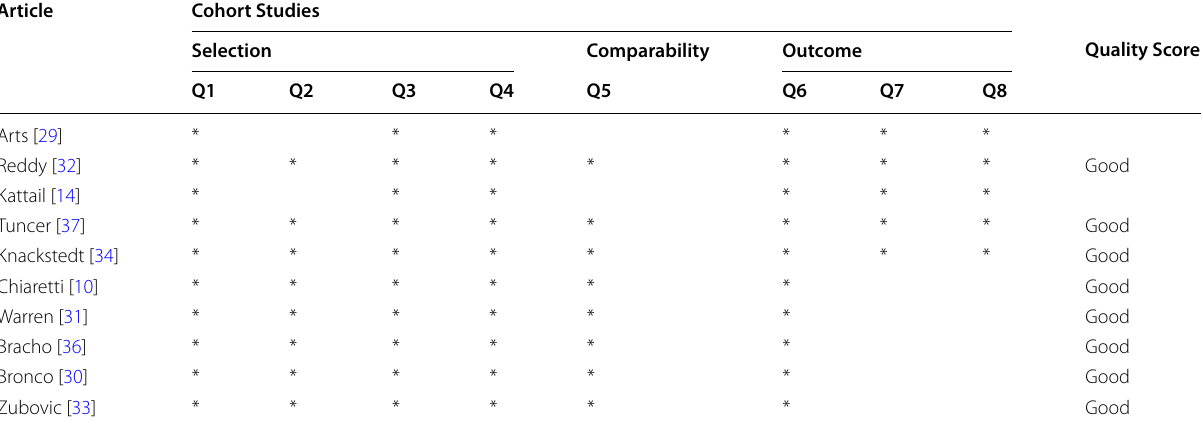
Table 5 The Newcastle–Ottawa Scale for the included cohort